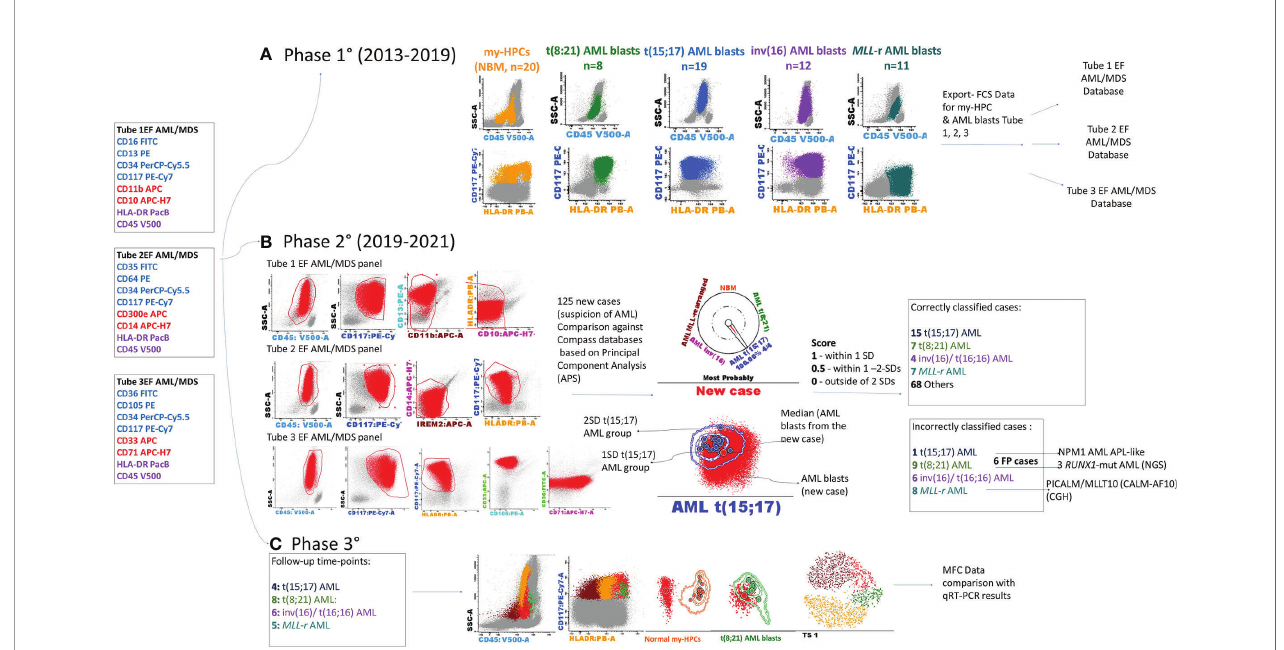
FIGURE 1 | Schematic overview of the study. The fi rst three tubes of the EuroFlow (EF) AML/MDS antibody panel were used for the discrimination of acute myeloid leukemia (AML) blasts and normal myeloid-committed hematopoietic precursors (my-HPCs) in bone marrow aspirates obtained from patients with AML and healthy individuals. (A) Phase 1: Construction of the databases. The Compass databases were composed of fcs-exported fi les corresponding to leukemic blasts from well- classi fi ed AML cases, according to the WHO diagnostic recommendations, including t (8;21) AML ( n = 8), t (15;17) AML ( n = 19), inv(16)/ t (16;16) AML ( n = 12), AML with MLL gene translocations ( MLL -r AML, n = 11), and normal my-HPCs ( n = 20). (B) Phase 2: Samples from 125 patients with suspected AML were compared against the Compass databases based on APS plots. The blast events from each individual AML case were compared against each well-classi fi ed AML group and with the normal my-HPC populations using balanced APS plots. The similarity between blast events from the new case and any de fi ned populations was scored based on the position of the median from the new case relative to the 1 and 2 standard deviation (SD) curves for the de fi ned AML groups or normal my-HPC groups included in the database. A total of 101 cases were correctly classi fi ed, whereas 24 cases were incorrectly assigned to the wrong AML group or to the other group. The incorrectly assigned t (15;17) AML case was an NPM1 + AML with an acute promyelocytic leukemia (APL)-like phenotype; the three false-positive t (8;21) AML cases were RUNX1 -mutant AML cases, and for the false-positive MLL -r AML case, the array-comparative genomic hybridization (CGH) analysis identi fi ed a PICALM/ MLLT10 ( CALM-AF10 ) fusion gene. (C) Phase 3: Evaluation of the Compass database-guided DfN analysis. Immunophenotypic data acquired at different MRD follow-up time points from four AML patients with different genetic abnormalities who were in cytological remission were used, including one MLL -r AML case, one t (8;21) AML case, one t (15;17) AML case, and one inv(16) AML case. Compass database-guided analysis was compared against quantitative reverse transcription – polymerase chain reaction